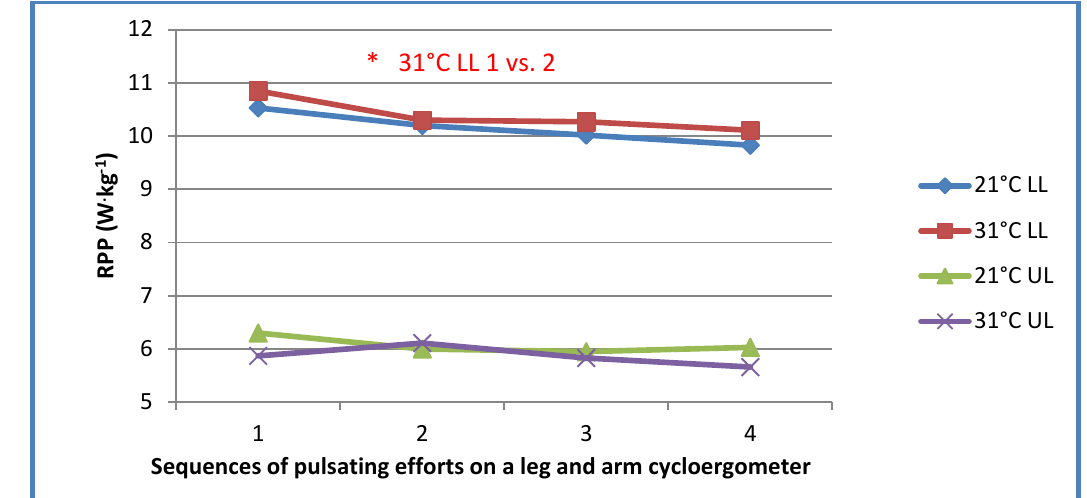
Figure 5. Relative peak power (RPP) values in the fourth of 5 series of physical exercises performed by the lower (LL) and upper limbs (UL) at ambient temperatures of 21 °C and 31 °C. * — significant differences at p < 0.05, 31 °C: differences between individual measurements.